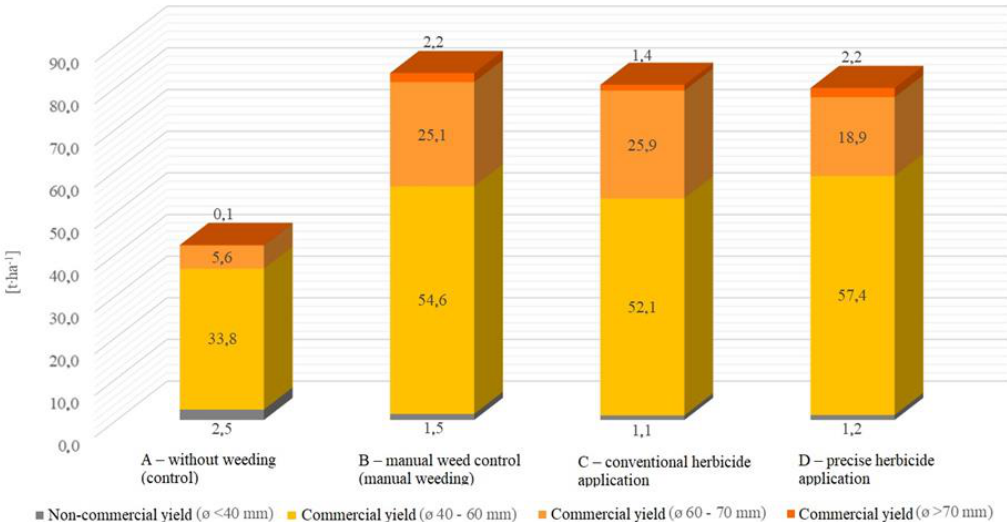
Figure 6. Average onion yield divided into fractions in 2016 (source: own work). In subsequent years of research, i.e., in 2017, in the case of non-commercial yield, its quantity was the largest in control objects and amounted to 3.8 t · ha − 1 , whereas it was slightly more than 1.5 t · ha − 1 in other cases. The average commercial yield for the methods marked as C and D was at a similar level and amounted to about 58 t · ha − 1 , similarly to the total yield (about 60 t · ha − 1 ) and slightly higher for the B method, and amounted to about 63 t · ha − 1 (commercial yield) and almost 65 t · ha − 1 (total yield). The control was characterized by a total yield of 38.7 t · ha − 1 and a commercial yield of 34.9 t · ha − 1 (Figure 7).